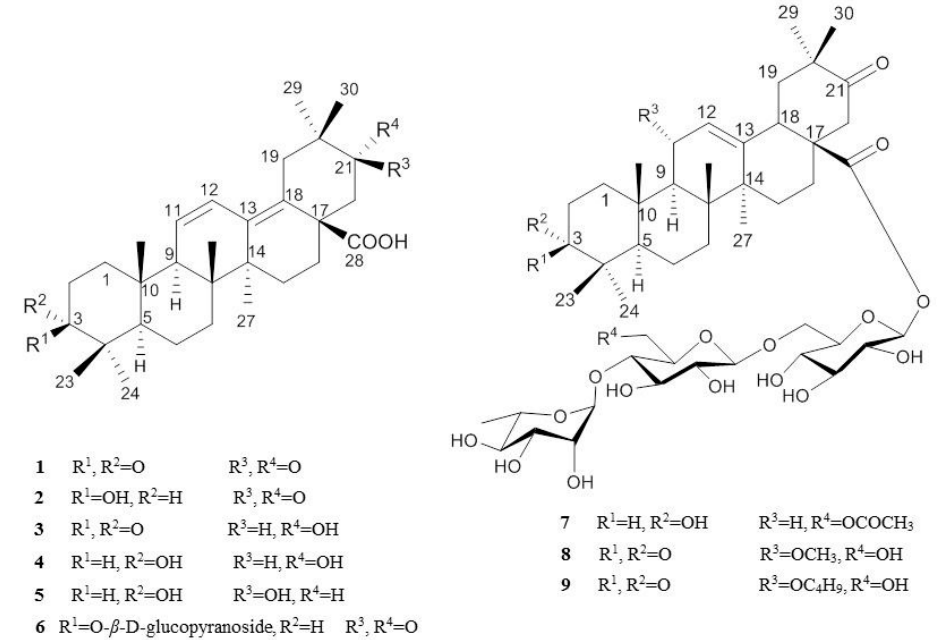
Figure 1. Isolated compounds from T. papyriferus .